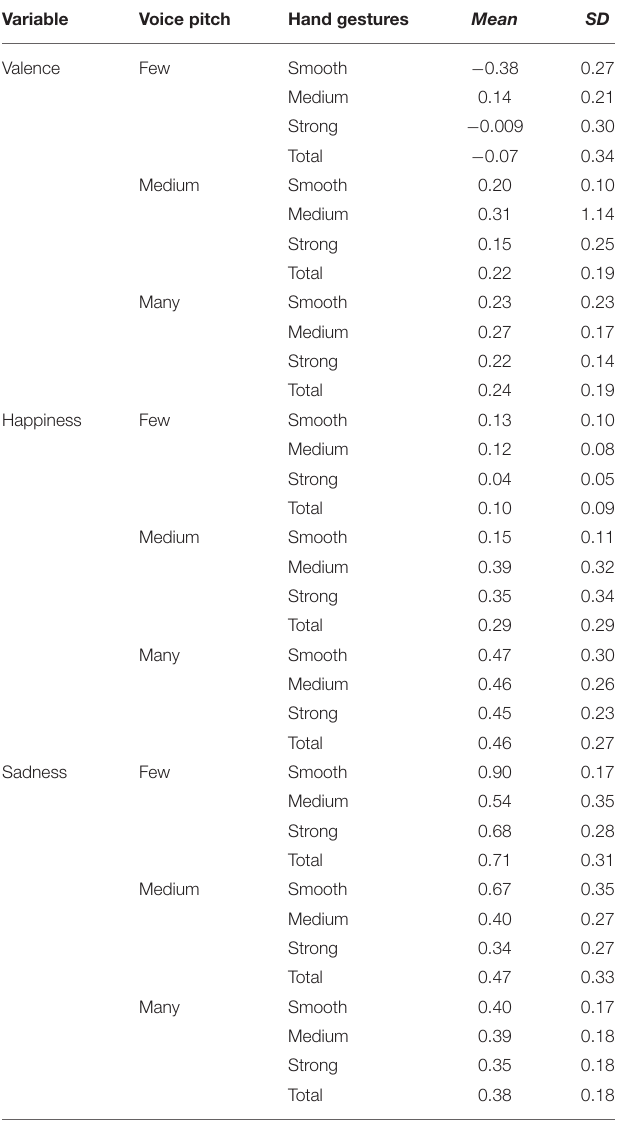
TABLE 3 | Valence, happiness, and sadness of voice pitch and hand gestures. Variable Voice pitch